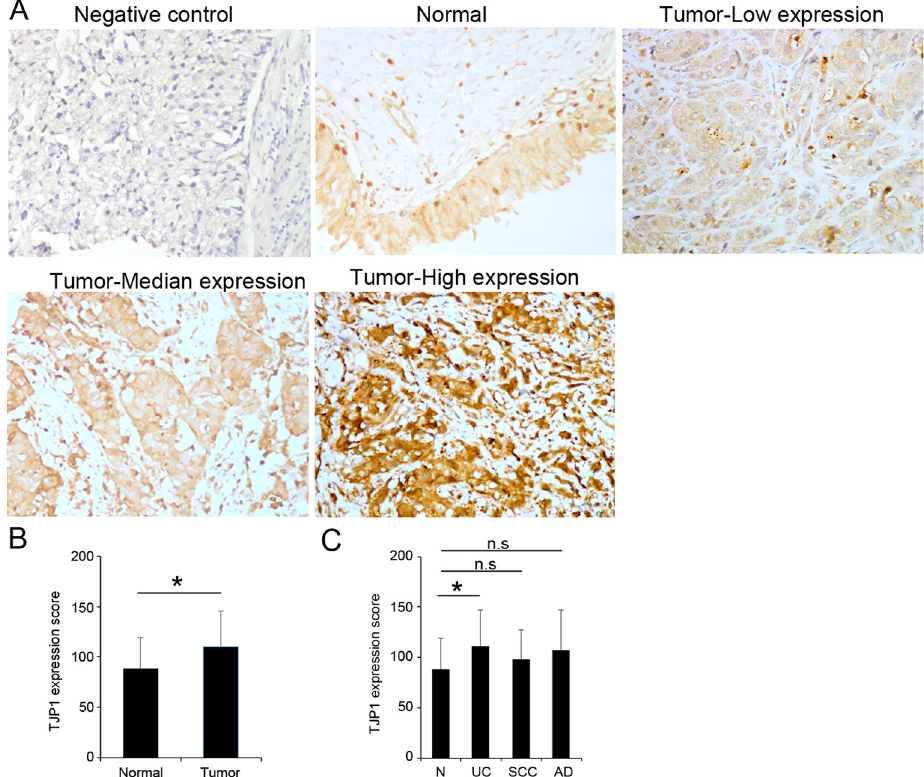
Figure 4. TJP1 upregulated in bladder cancer. ( A ) Representative IHC staining images of TJP1 in bladder cancer tissues. ( B ) Relative TJP1 protein levels in adjacent non-tumor tissue (n = 16) and bladder cancer tissues (n = 192). ( C ) Relative TJP1 protein levels in urothelial carcinoma (UC, n = 160), squamous cell (SCC, n = 16) and adenocarcinoma (AD, n = 16) in bladder cancer tissues. Data are presented as the mean ± SD, * p < 0.05. ns not significant.